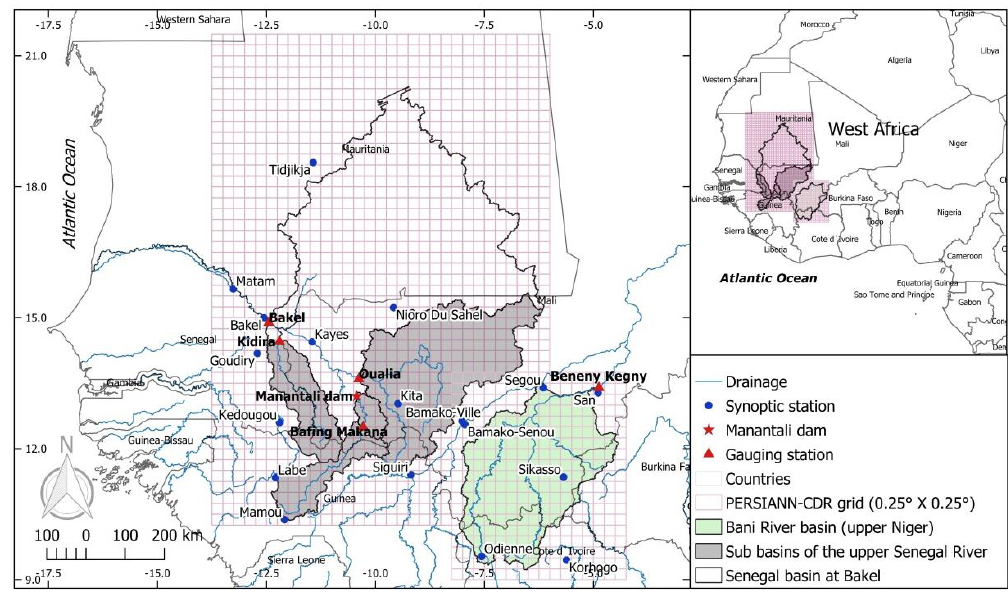
Figure 1. Location of Upper Senegal River and Bani River basins, synoptic and hydrometric stations, and PERSIANN-CDR grids.